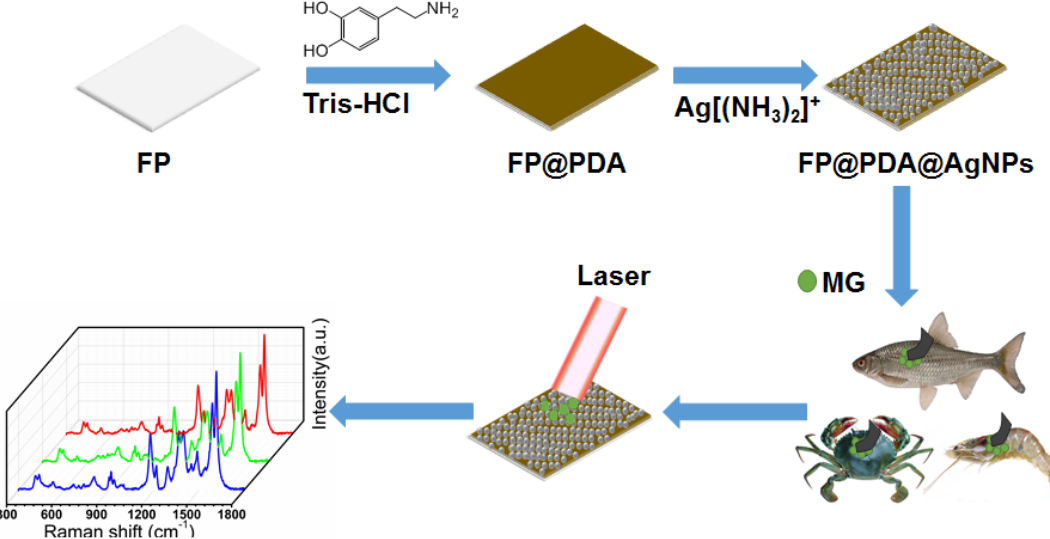
Figure 1. Schematic diagram of the preparation of flexible filter paper@polydopamine@silver nanoparticles (FP@PDA@AgNPs) surface ‐ enhanced Raman spectroscopy (SERS) sensors for SERS detection of malachite green (MG) residues in aquatic products.